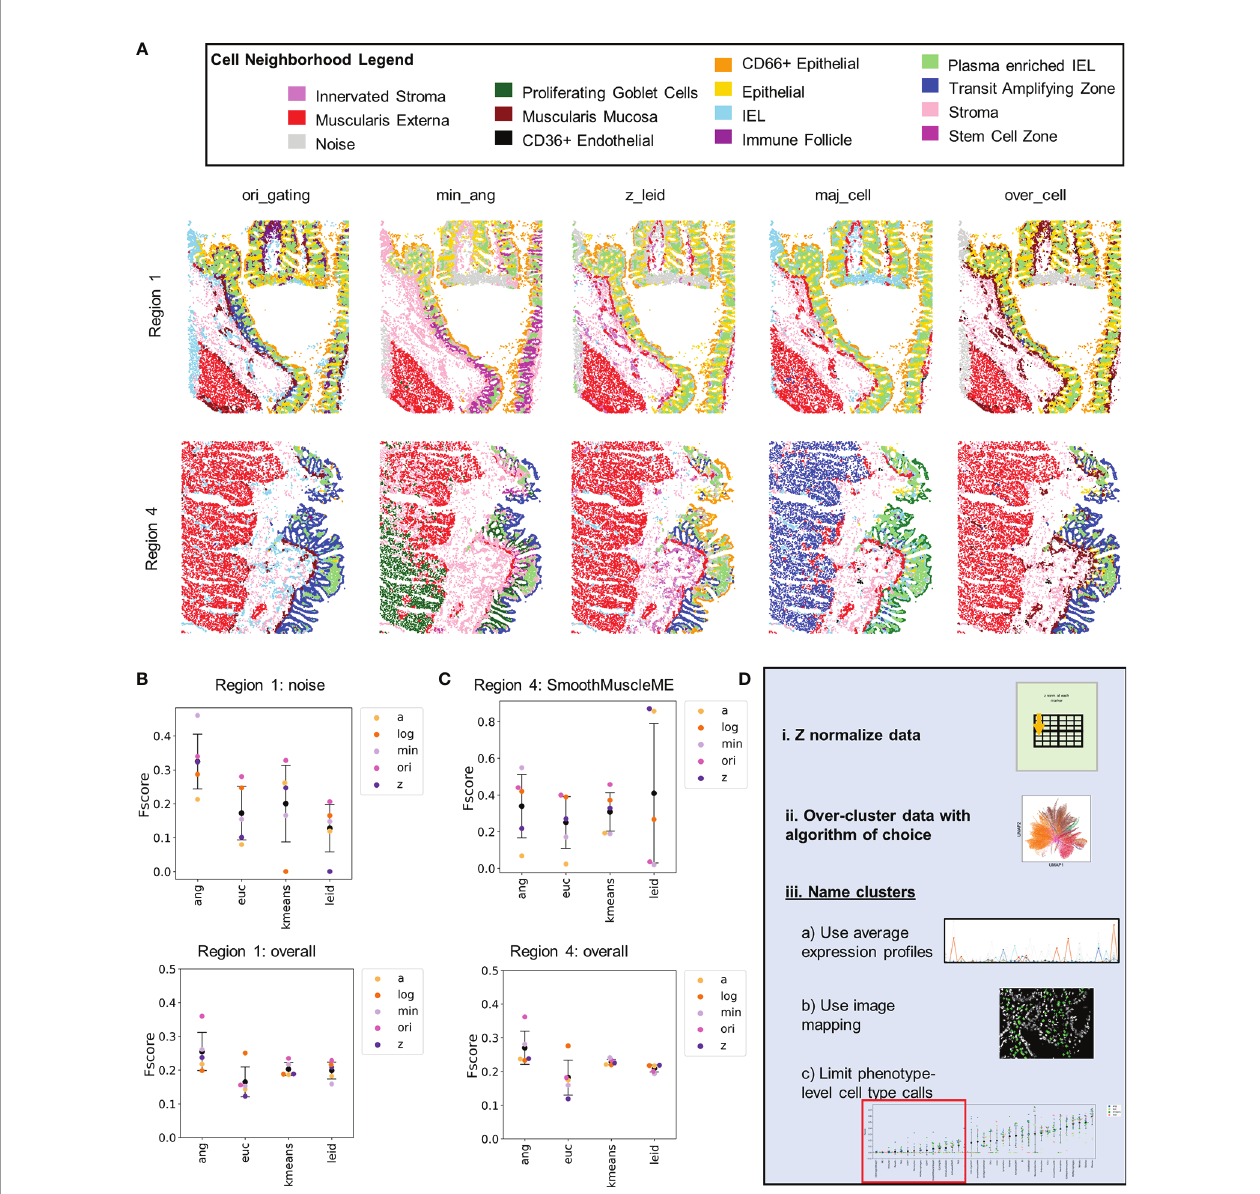
FIGURE 6 | Cellular neighborhood analysis reveals additional noisy cell populations that can be managed by data normalization. (A) Cellular neighborhoods shown for Region 1 and 4 for fi ve of the 23 cell-type annotations. (B) Level 1 F-score averages for Region 1 for the noise cell type and averaged across all cell types. (C) Level 1 F-score averages for Region 1 for the smooth muscle muscularis externa cell type and averaged across all cell types (black data point is mean and error bars indicate standard deviation). (D) Recommendations for normalization and cell type annotations of segmented single-cell CODEX